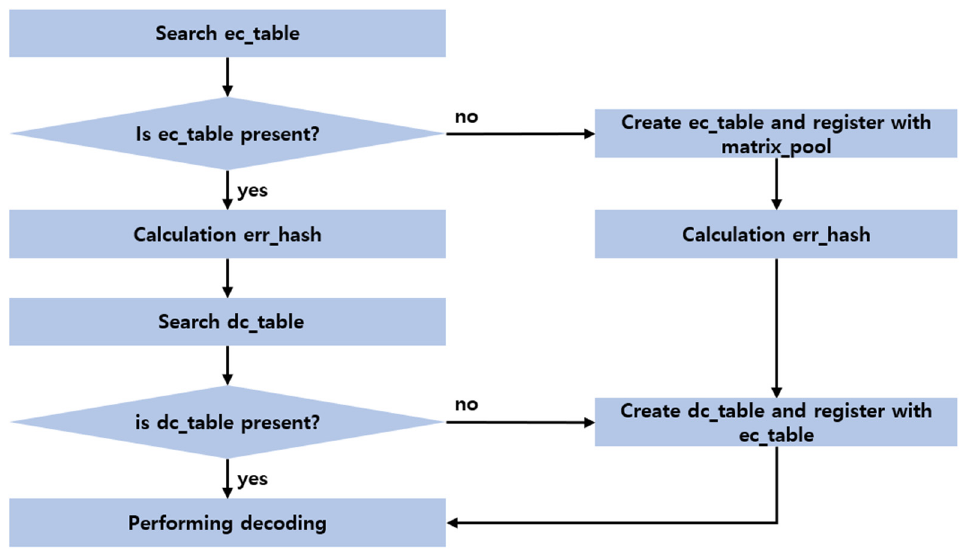
Figure 19. Matrix recycle step.